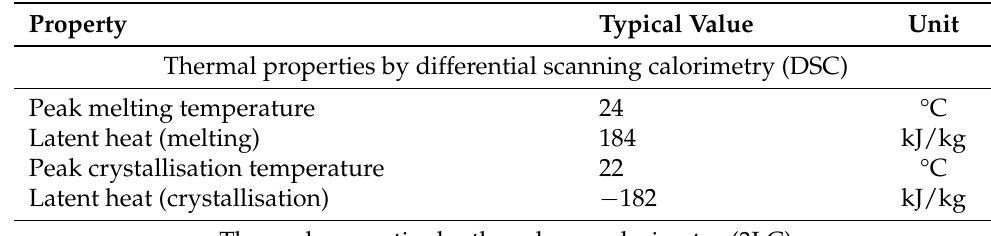
Table 1. Physical properties of CrodaTherm